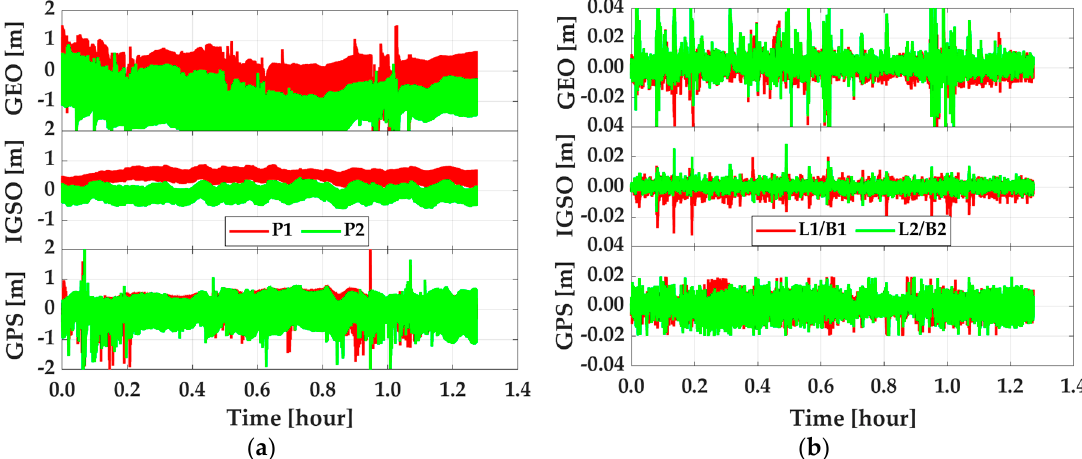
Figure 9 . Code residuals ( a ) and phase residuals ( b ) of GEO, IGSO, and GPS satellites. Table 3. RMS of residuals of codes (P1 and P2) and phases (GPS: L1 and L2, BDS: B1 and B2) of GEO, IGSO,